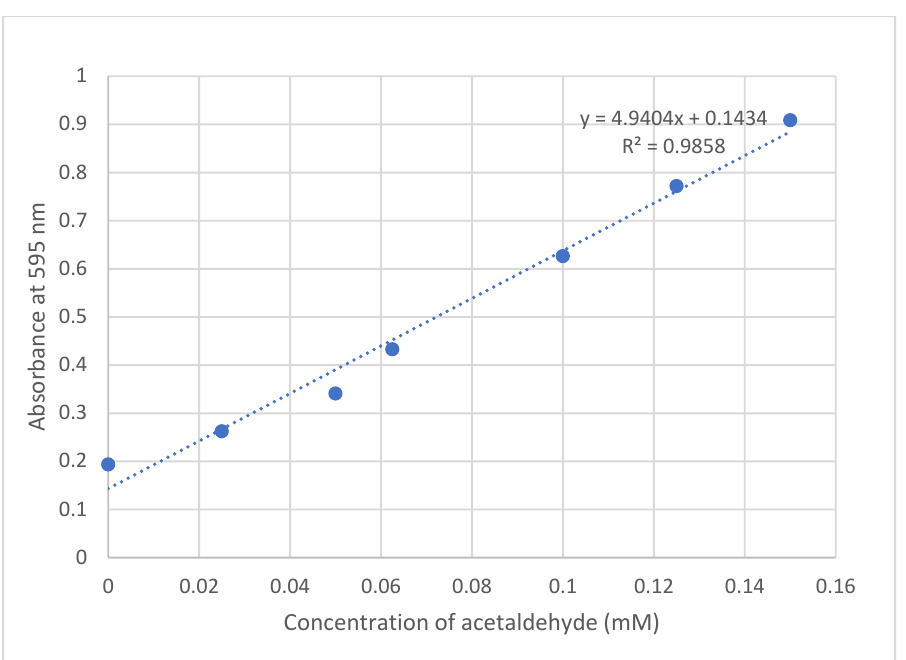
Figure 8. Standard curve of acetaldehyde by MBTH derivatization against absorbance at 595 nm.